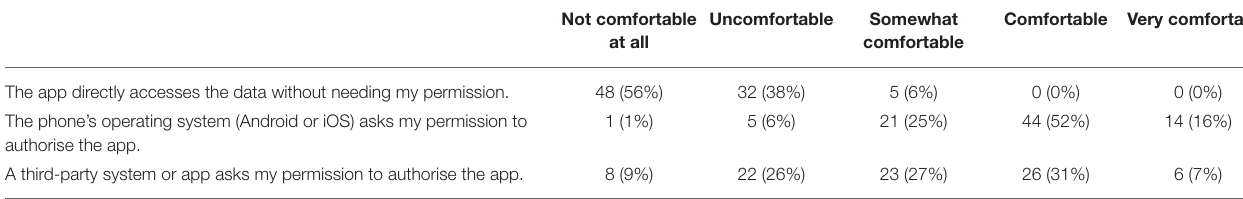
TABLE 10 | Answers to the question “If an app needs to access sensitive information from your phone (for example, your geographical position), what option would you feel more comfortable with?” ( n = 85).